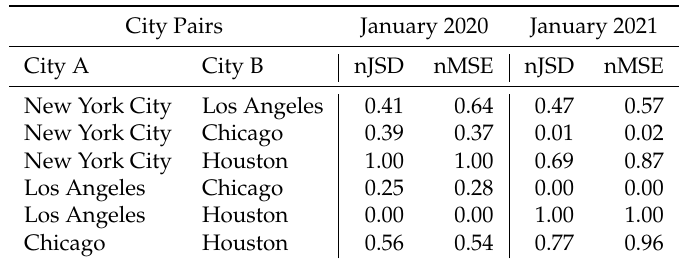
Table 3: Normalized Jensen-Shannon Distance dissimilarity values and normalized mean square error for each pair of cities split by time